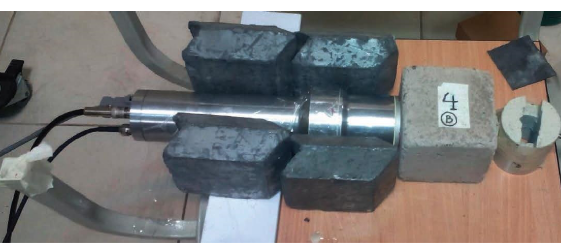
Figure 6: Gamma ray attenuation.